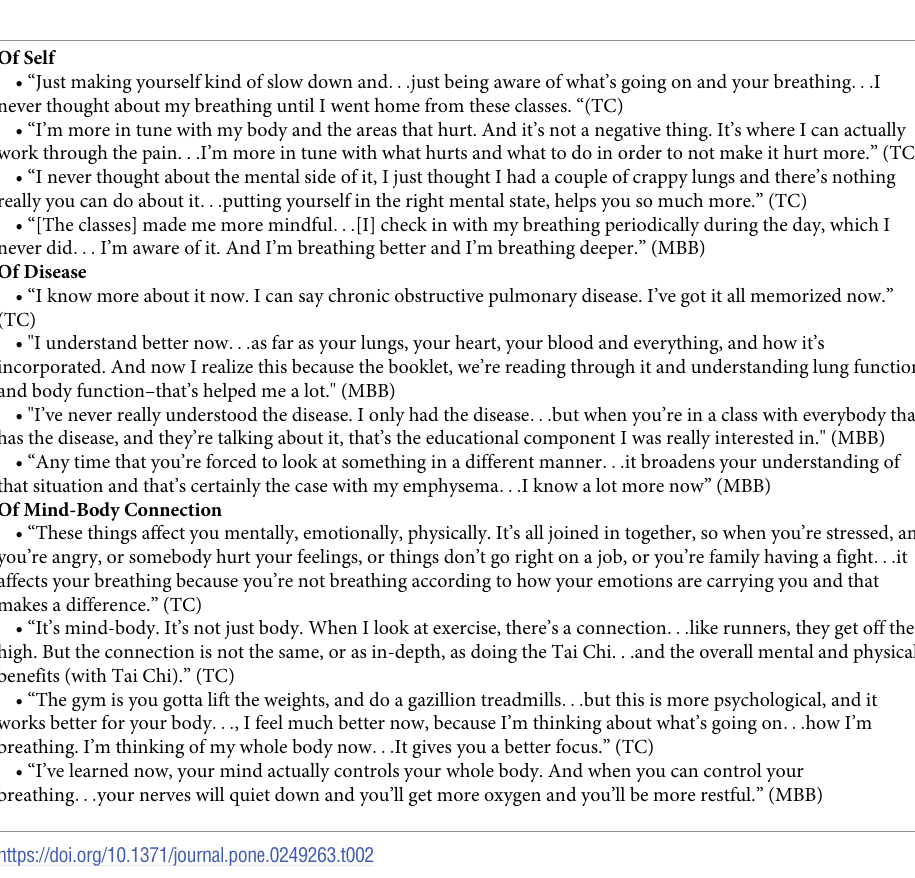
Box 1. Representative quotes related to ‘overall awareness and